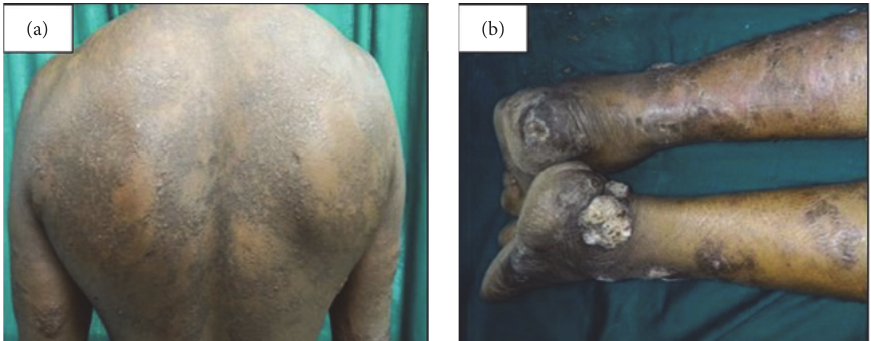
Figure 1: (a) Multiple, soft, nontender, skin coloured superficial nodules present bilaterally on the forearms and back. (b) Multiple verrucous plaques were seen over the right ankle.